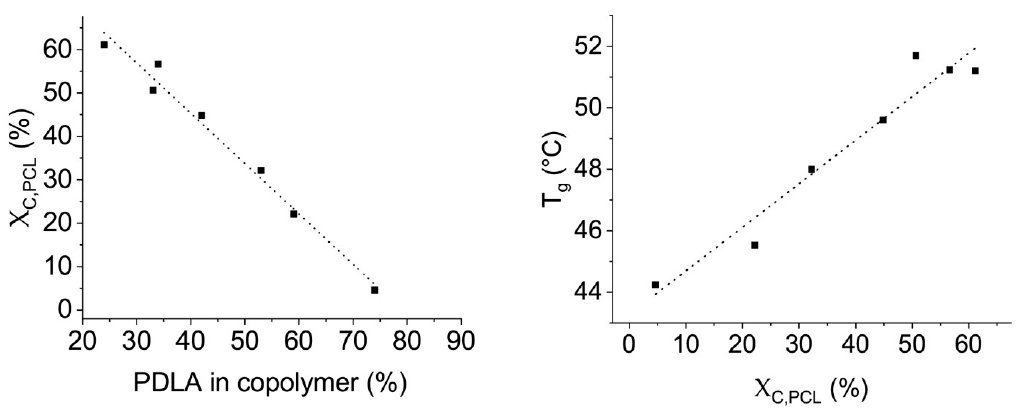
Figure 4. Dependence of the crystallinity of the PCL phase on the PCL fraction in the block copolymer ( left ) and the glass transition temperature of the PLLA phase on the crystallinity of the PCL phase ( right ). The drawn straight lines represent the results of linear regression calculations.